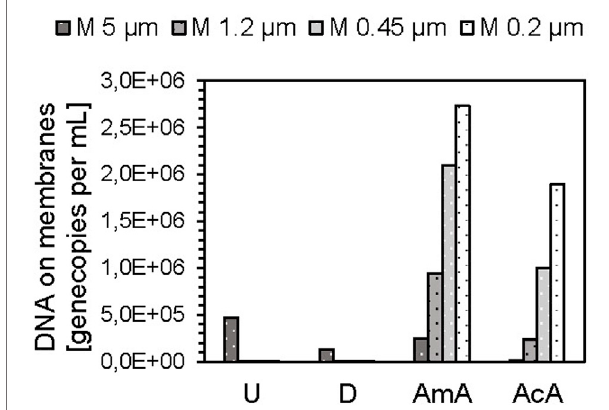
FIGURE 3 | eARG/DNA fragments on membranes after DNA extraction of cascade fi ltration experiments with silica particles in ultrapure water (U, pH 7), drinking water (D, pH 7), amino acid buffer (AmA, pH 5), and acetic acid buffer (AcA, pH 5).